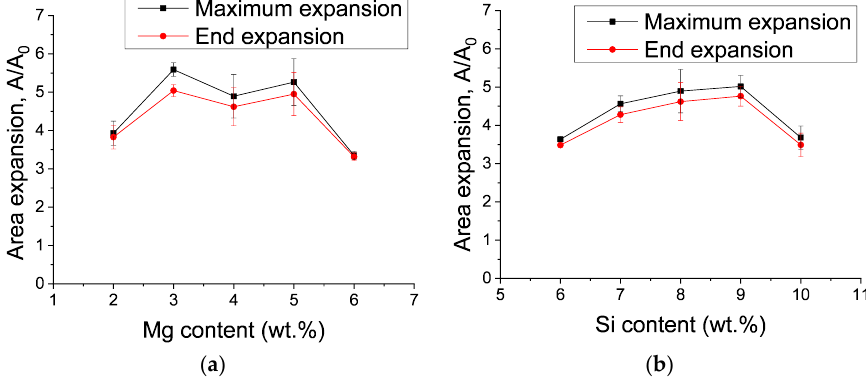
Figure 4. Maximum and end foam area expansion given as a function of ( a ) Mg content, with Si fixed at 8 wt.%, and ( b ) Si content, with Mg fixed at 4 wt.%.